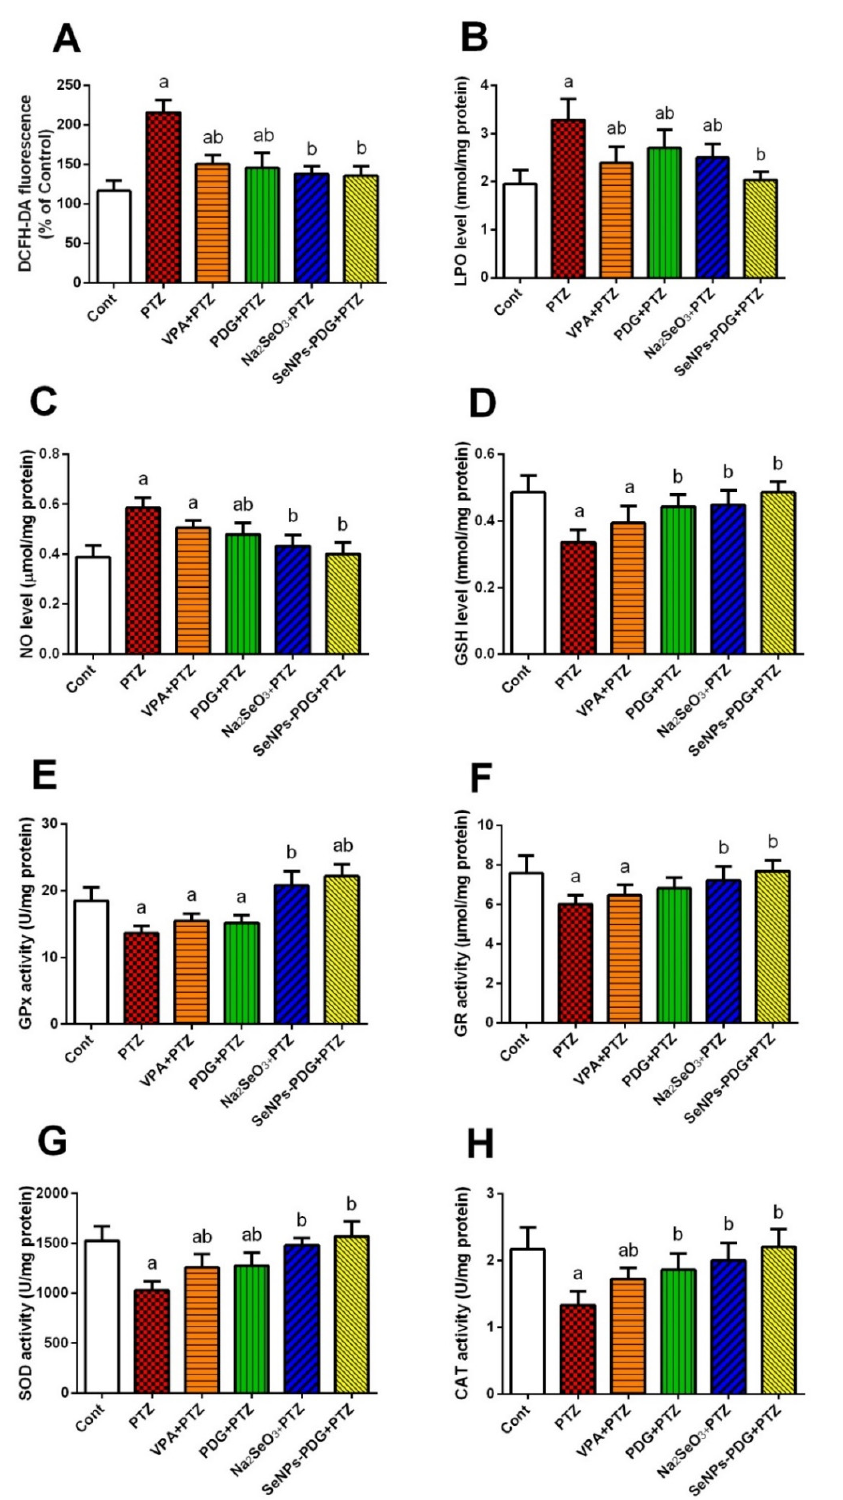
Figure 1. Effects of orally administered prodigiosin (PDG), sodium selenite (Na 2 SeO 3 ), and green biosynthesized SeNPs with PDG (SeNPs-PDG) on the hippocampal levels of ( A ) reactive oxygen species (ROS), ( B ) malondialdehyde (MDA), ( C ) nitric oxide (NO), ( D ) glutathione (GSH), ( E ) glu- tathione peroxidase (GPx), ( F ) glutathione reductase (GR), ( G ) superoxide dismutase (SOD), and ( H ) catalase (CAT) following pentylenetetrazole (PTZ)-induced epileptic seizures. a and b denote significant differences ( p < 0.05) compared with the untreated control and PTZ-injected groups, re- spectively. All records are presented as the mean ± standard deviation (SD).